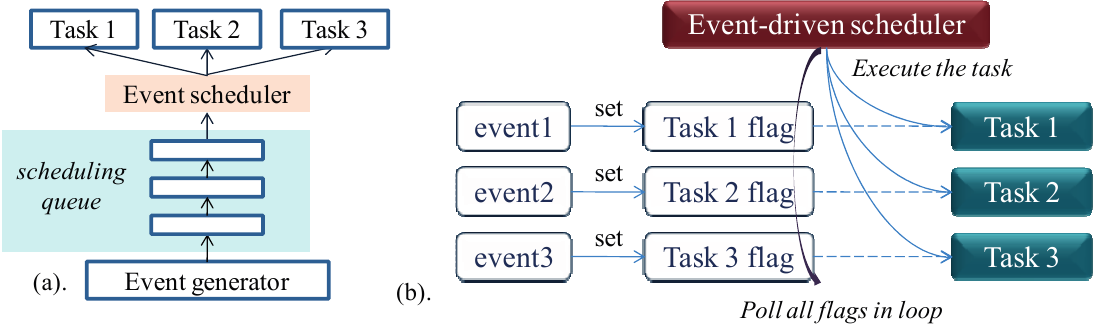
Figure 2. Event-driven scheduling structure. ( a ) General event-driven scheduling structure. ( b ) MIROS event-driven scheduling